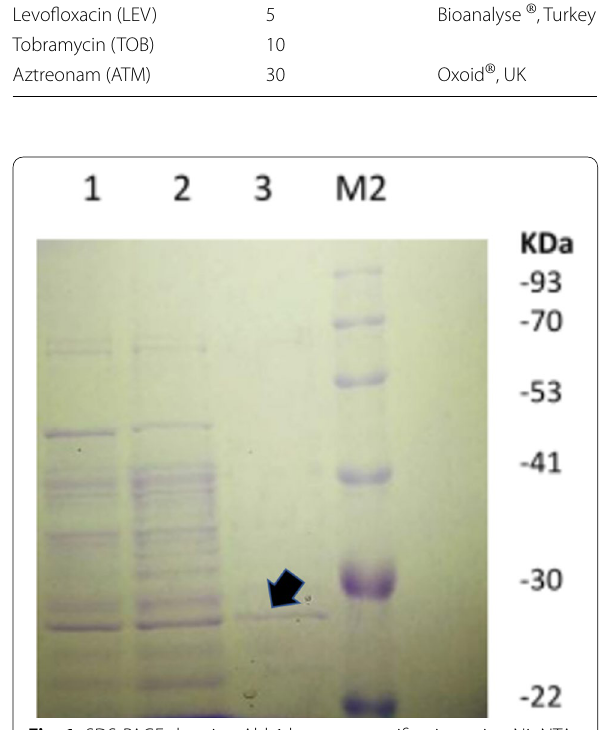
Fig. 1 SDS-PAGE showing Ahl-1 lactonase purification using Ni–NTA spin column. Lane1: flow through, Lane 2: wash 1, Lane 3: purified Ahl-1 in the elution buffer (indicated by an arrow), M2: protein ladder (New England Biolabs,